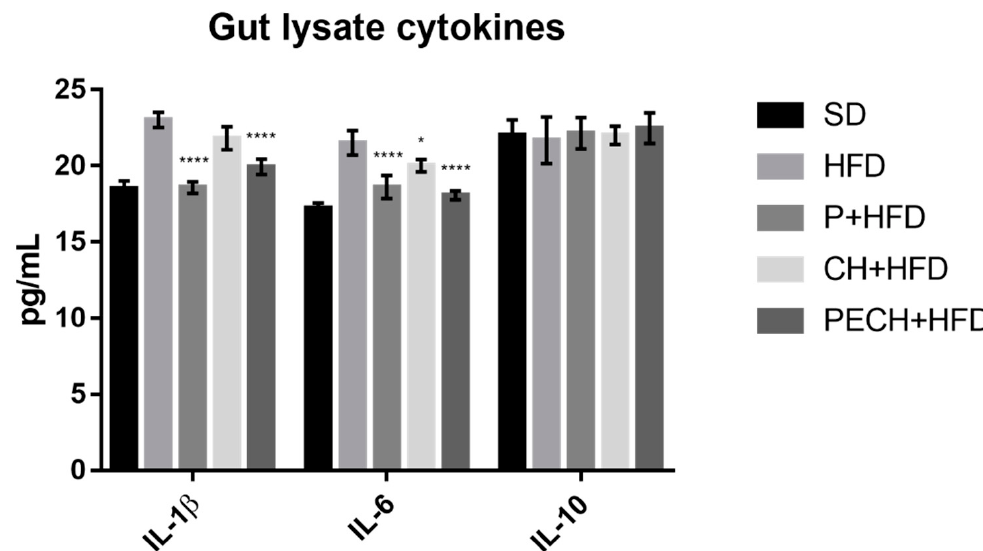
Figure 5. E ff ect of di ff erent diets on gut lysate cytokines. The di ff erent diets compared were standard diet, (SD, n = 4), high-fat diet (HFD, n = 8), phenolic-enriched high-fat diet (P + HFD, n = 8), lyophilized cooked ham enriched high-fat diet (CH + HFD, n = 8) and lyophilized phenolic enriched cooked ham enriched high-fat diet (PECH + HFD, n = 8) on inflammatory biomarkers IL-1 β , IL-6 and IL-10 in gut samples. HFD mean results were compared against P + HFD, CH + HFD and PECH + HFD diets, significant di ff erences are expressed as * p < 0.05 ** p < 0.01 *** p < 0.001 **** p < 0.0001.